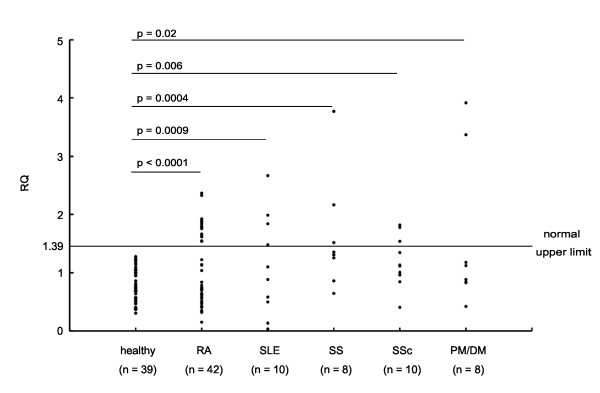
Evaluation of hRasGRP4 mRNA levels in PBMCs. A qPCR approach was used to quantify the overall levels of hRasGRP4 transcripts in the peripheral blood mononuclear cells (PBMCs) from healthy individuals and patients with rheumatoid arthritis (RA) and other rheumatic diseases such as SLE, Sjögren's syndrome (SS), systemic sclerosis (SSc), and polymyositis/dermatomyositis (PM/DM). Shown are the relative quantities (RQ) of human glyceraldehyde-3-phosphate dehydrogenase (hGAPDH)-corrected levels of the hRasGRP4 transcript in each sample. One of the healthy individuals was assigned to determine the value of 1. In all of the healthy individuals and patients, assays were done in a triplicate manner and mean values are plotted in the figure. Normal upper limit of the transcript level was defined as mean transcript level + 2SD of the healthy controls. Numbers of the patients whose hRasGRP4 transcript levels are above the normal upper limit were evaluated using Fisher's exact test.